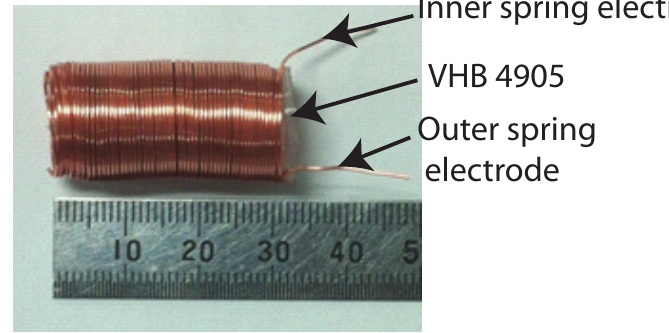
Figure 5. Photograph of fabricated spring-based-electrode cylindrical DEA.